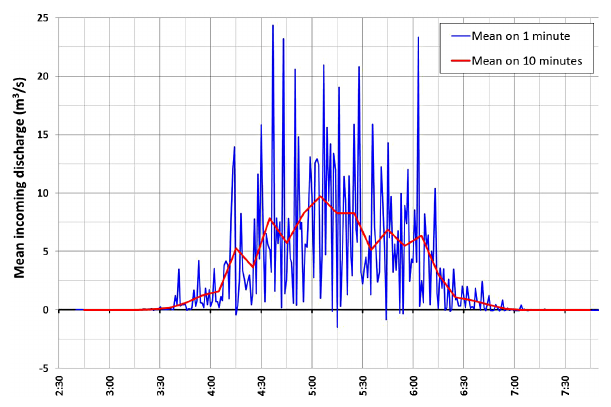
Figure 9. Evolution of the overtopping flow rate versus time (es- timated at the time steps of 1 and 10min) during the SURF-WB simulation.